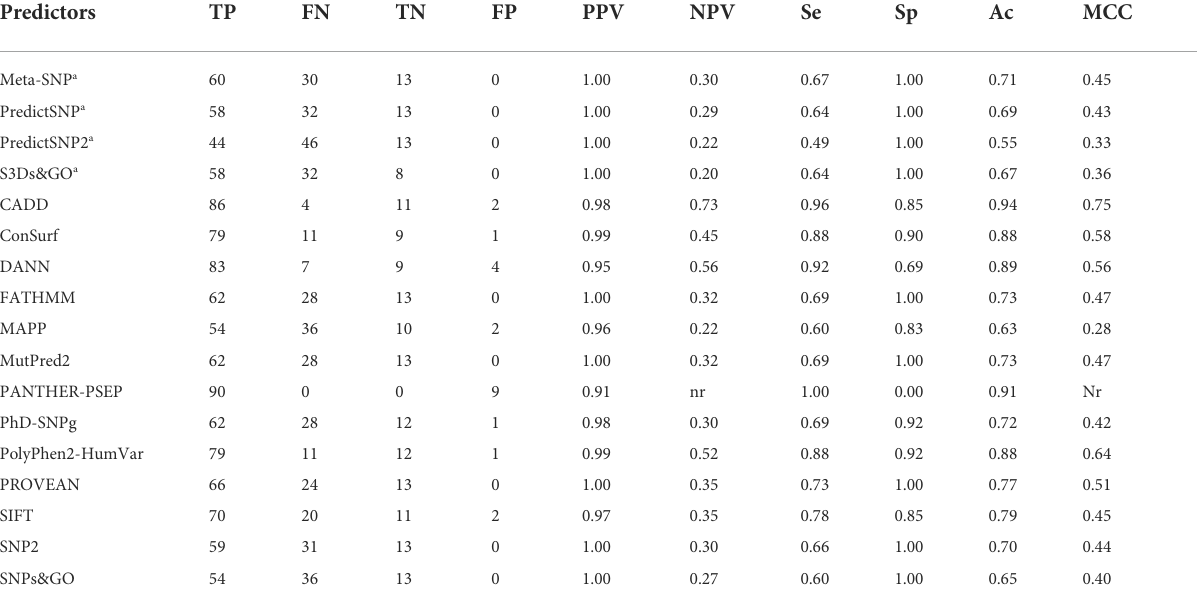
TABLE 1 Performance of 17 programs to predict the effect SNVs in the CYP21A2 . We performed the analysis with 103 functionally characterized variants, 90 damaging the protein functionality, and 13 neutral — Color scores from blue (good result) to yellow (not good).